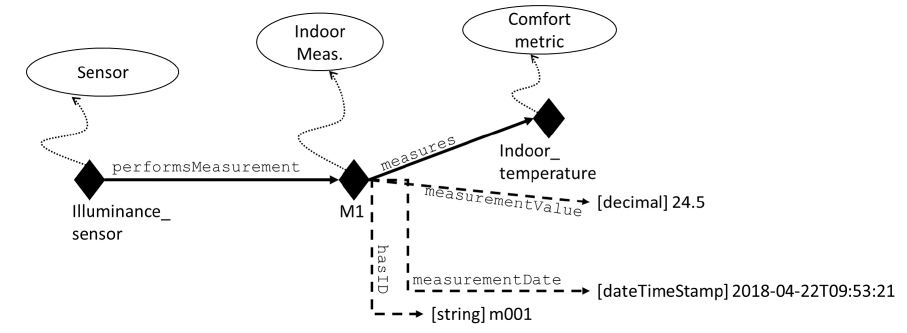
Figure 4. An example of sensor modelling and its